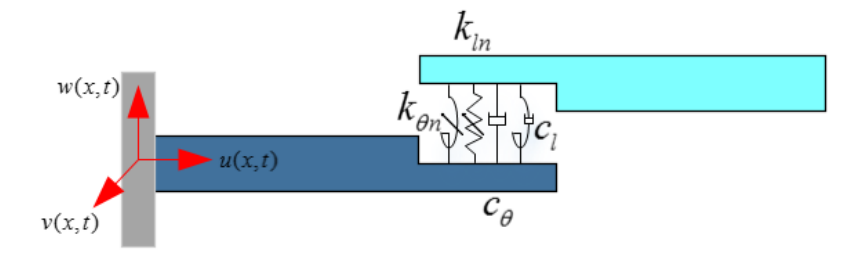
Figure 5. Schematic diagram of bolted cantilever beam.